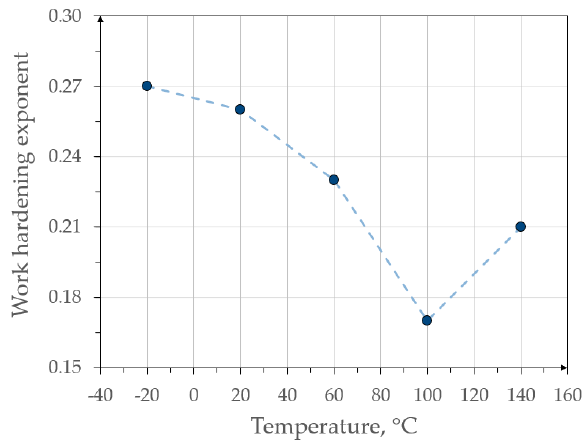
Figure 4. Maximum values of work hardening exponent at various temperatures.